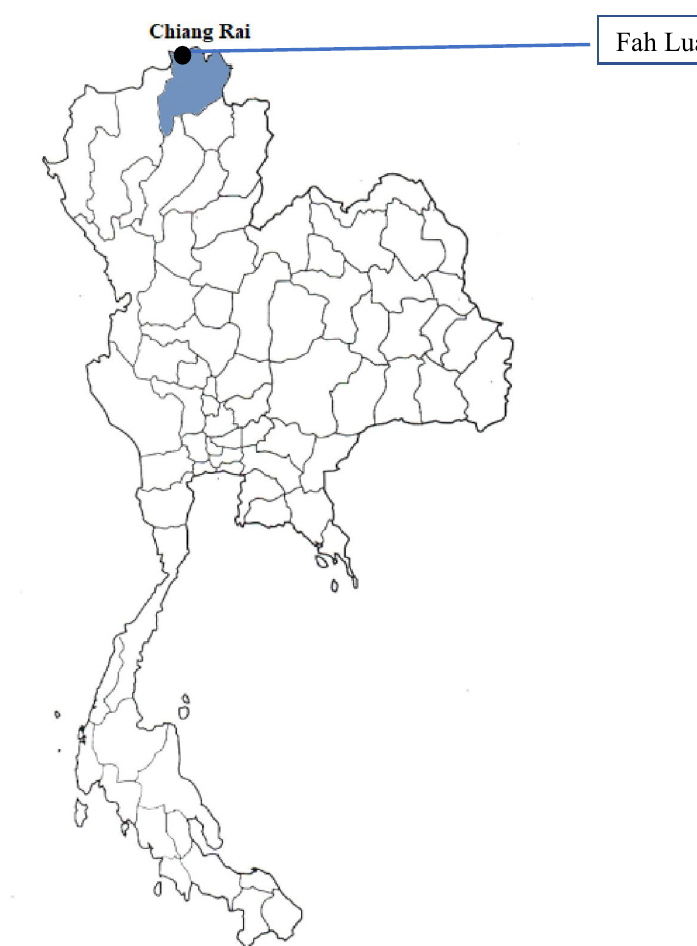
Figure 1. Map of the study hill tribe villages in Mae Fah Luang District, Ching Rai Province,